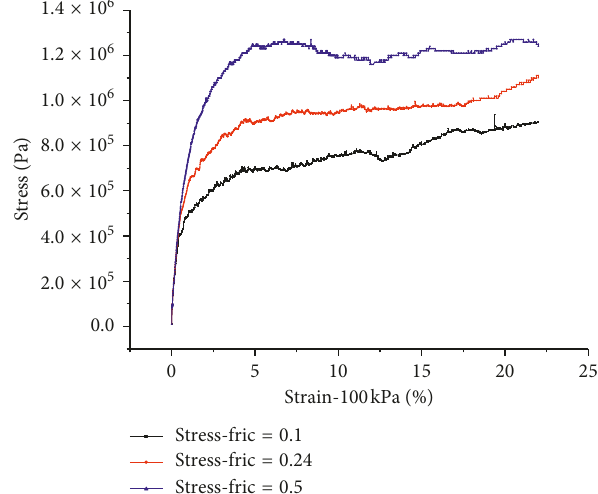
Figure 5: Stress-strain of different contact weathered mudstone layers with different-density sand and gravel layers to achieve the purpose of highlighting the research.